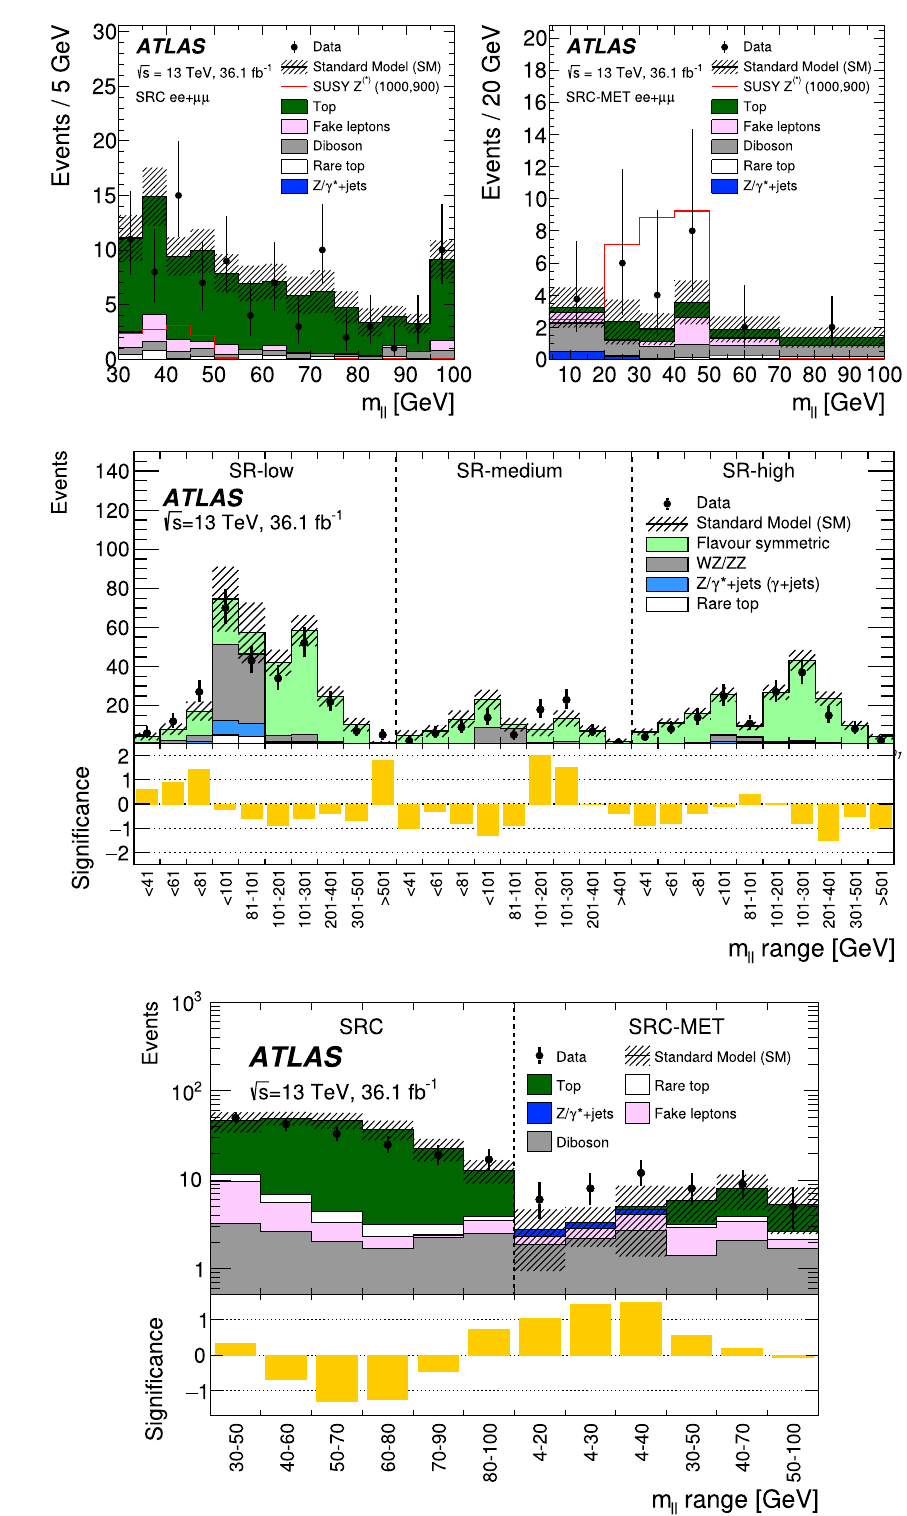
Fig. 10 Observed and expected dilepton mass distributions, with the bin boundaries considered for the interpretation, in (left) SRC and (right) SRC-MET of the low- p T edge search. All statistical and systematic uncertainties of the expected background are included in the hatched band. An example signal from the Z ( ∗ ) model with m ( ˜ g ) = 1000 GeV and ) = 900 GeV is overlaid m ( ˜ χ 0 1